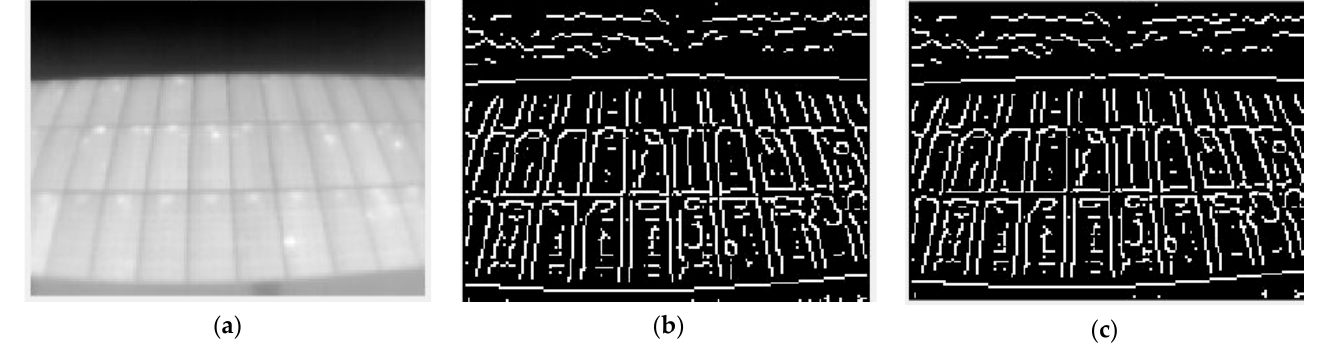
Figure 4. Different applications of edge detection filters for the same image. ( a ) Raw image; ( b ) Sobel filter; ( c ) Canny filter.